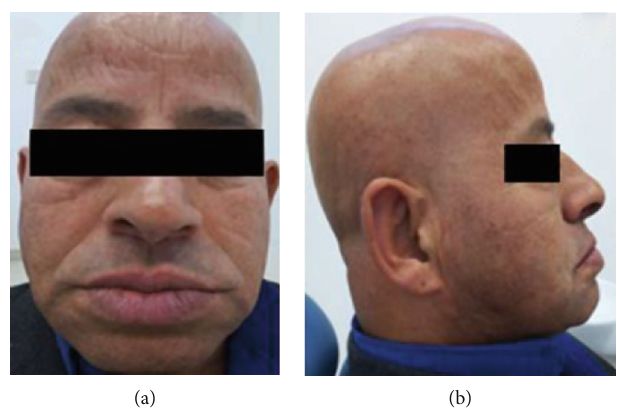
Figure 1: Extraoral appearance: (a) front view and (b) side view.